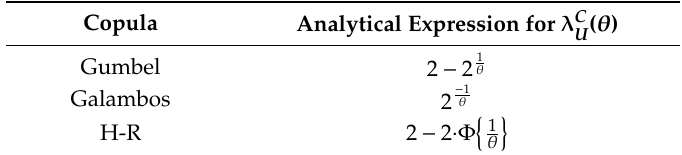
Table 2. Tail dependence coe ffi cient for each of the tested